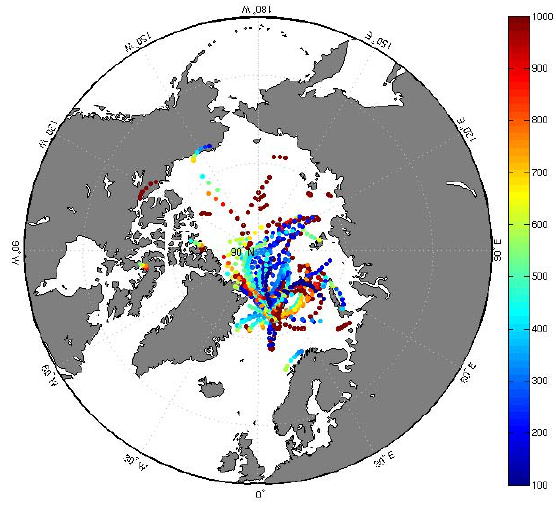
Fig. 5. 2-day back trajectories arriving in Ny- ˚Alesund during periods with high RGM concentrations ( > = 75 percentile, i.e. 26pgm − 3 ) .